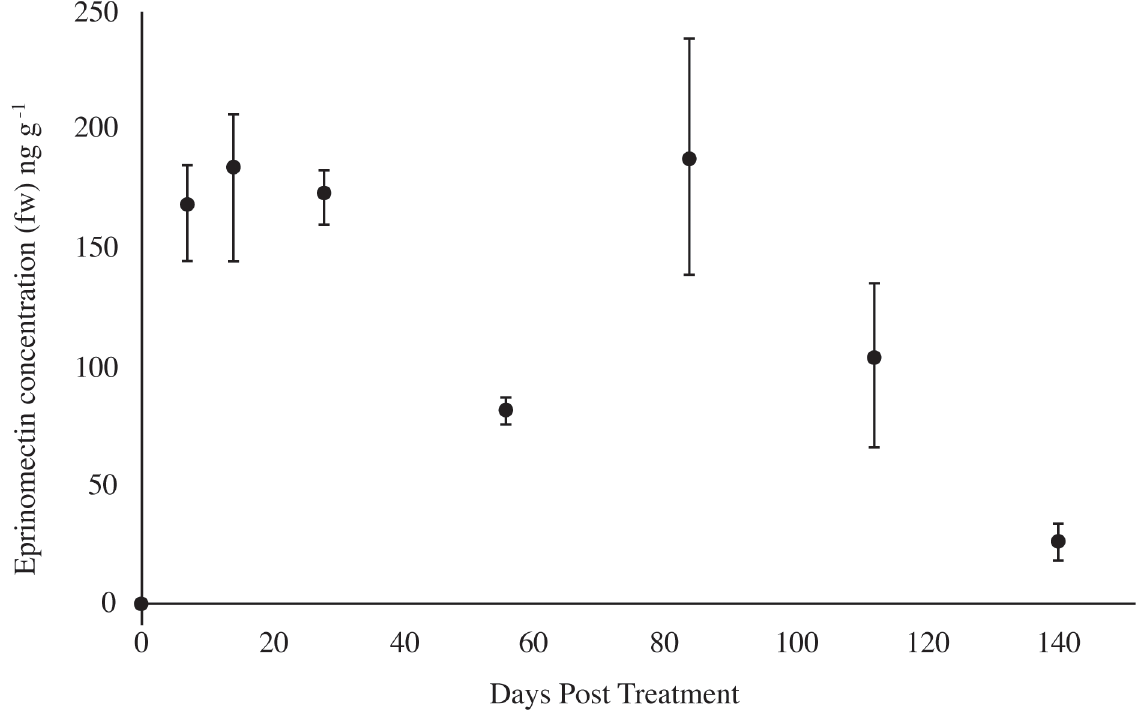
Fig 3. Eprinomectin concentration in cattle dung. Excretion profile of eprinomectin in dung (fresh weight, fw; mean ± minimum and maximum values of 3 replicates; n = 8) of cattle collected before (day 0) and 7, 14, 28, 56, 84, 112 and 140 d after LongRange treatment.